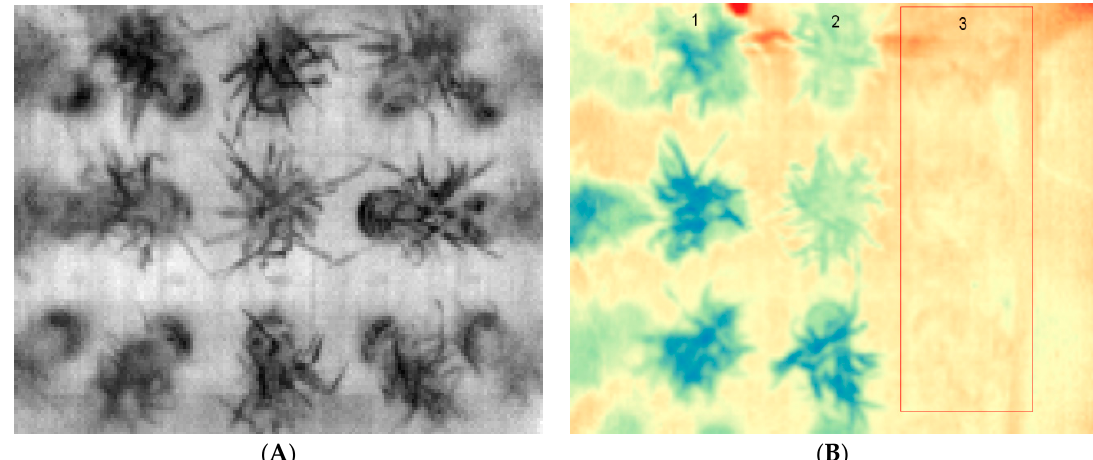
Figure 3. Visualization of a thermal image using the software QGIS (QGIS Geographic Information System) : ( A ) left side original image: ( B ) image with pseudocolor, plants in the first and second column (1, 2) show lower near infrared values (color blue), while plants in the third column (3) (red and yellow color) marked with the red frame show higher values (plants under drought conditions).